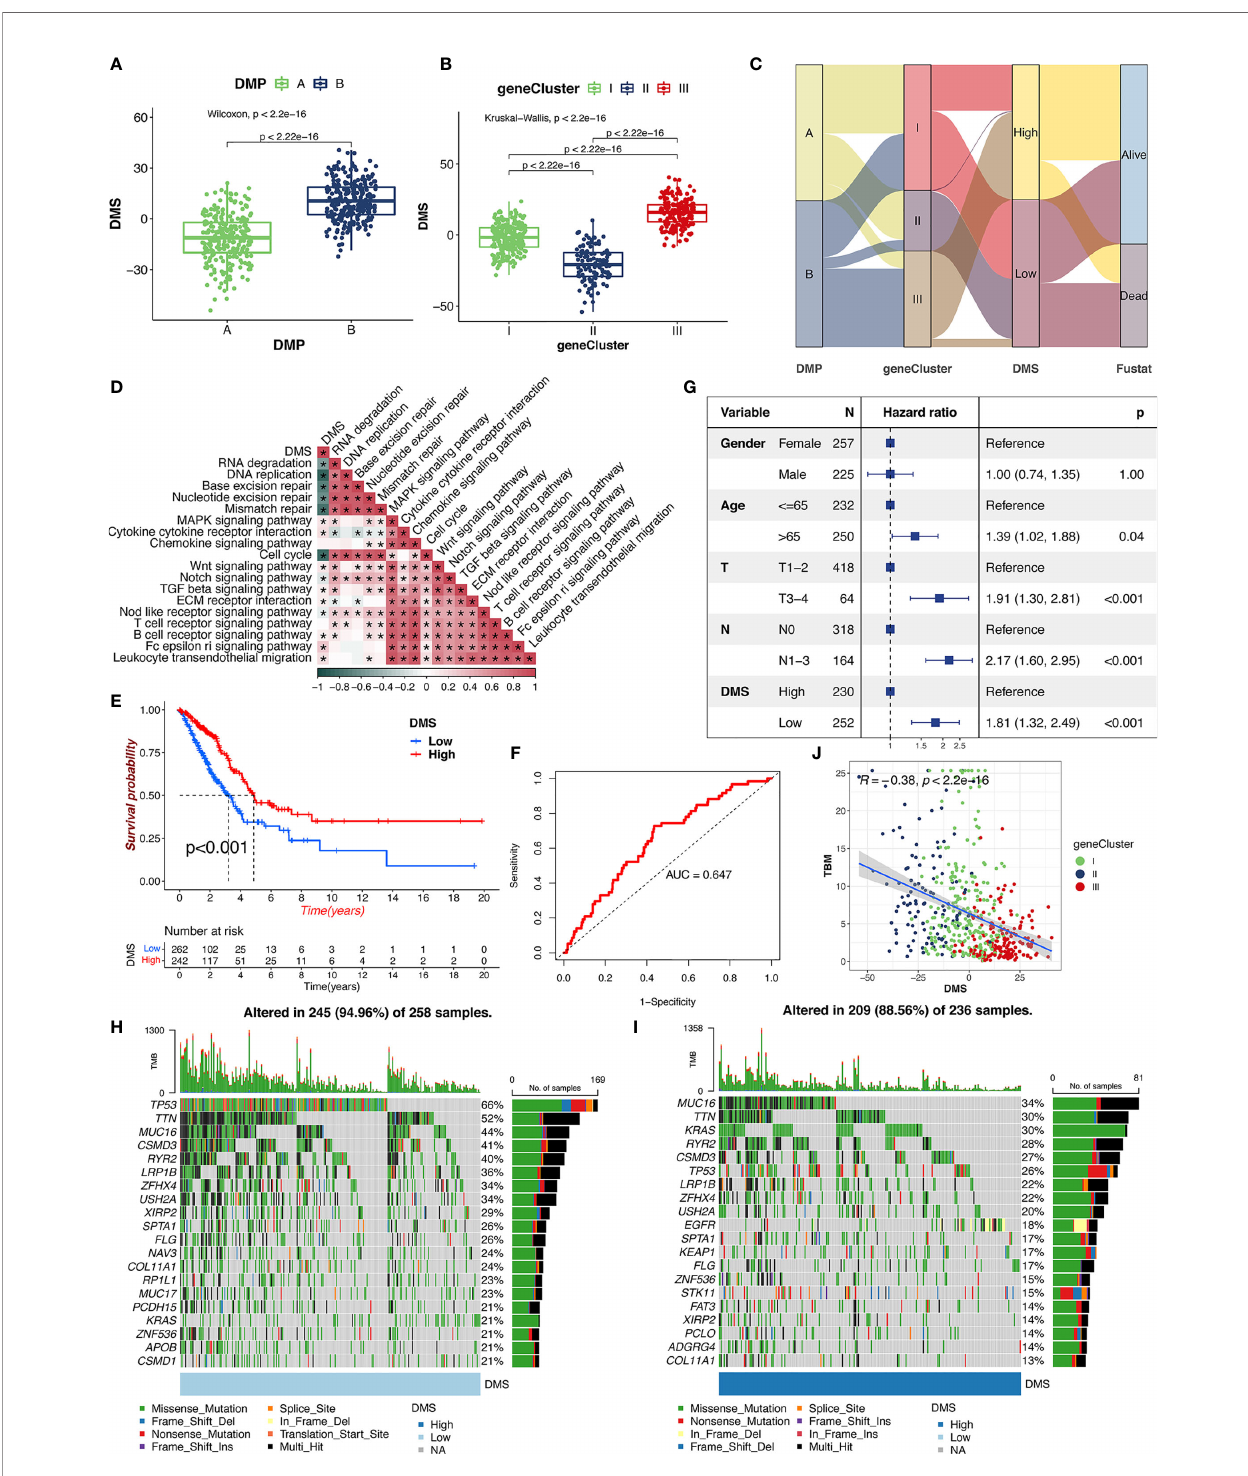
FIGURE 5 | The clinical characteristics of DMS. (A) Distribution of DMS in distinct DMPs in TCGA cohort. The Wilcoxon text, p < 0.001. (B) Distribution of DMS in distinct gene clusters in TCGA cohort. The Kruskal-Wallis text, p < 0.001. (C) The alluvial diagram of the relationship among DMPs, gene clusters, DMS, and prognosis. (D) The correlations between DMS and the enriched gene signal pathways in TCGA cohort using the Spearman ’ s test. (E) Survival analysis of high- and low-DMS groups in TCGA cohort. Log-rank text, p < 0.001. (F) The predictive value of the DMS signatures in TCGA cohort. (G) Multivariate Cox regression analysis for DMS in TCGA cohort. (H, I) The landscape of tumor somatic mutation in TCGA cohort evaluated between low (H) and high (I) DMS. (J) Correlations between DMS, TBM, and gene cluster in TCGA